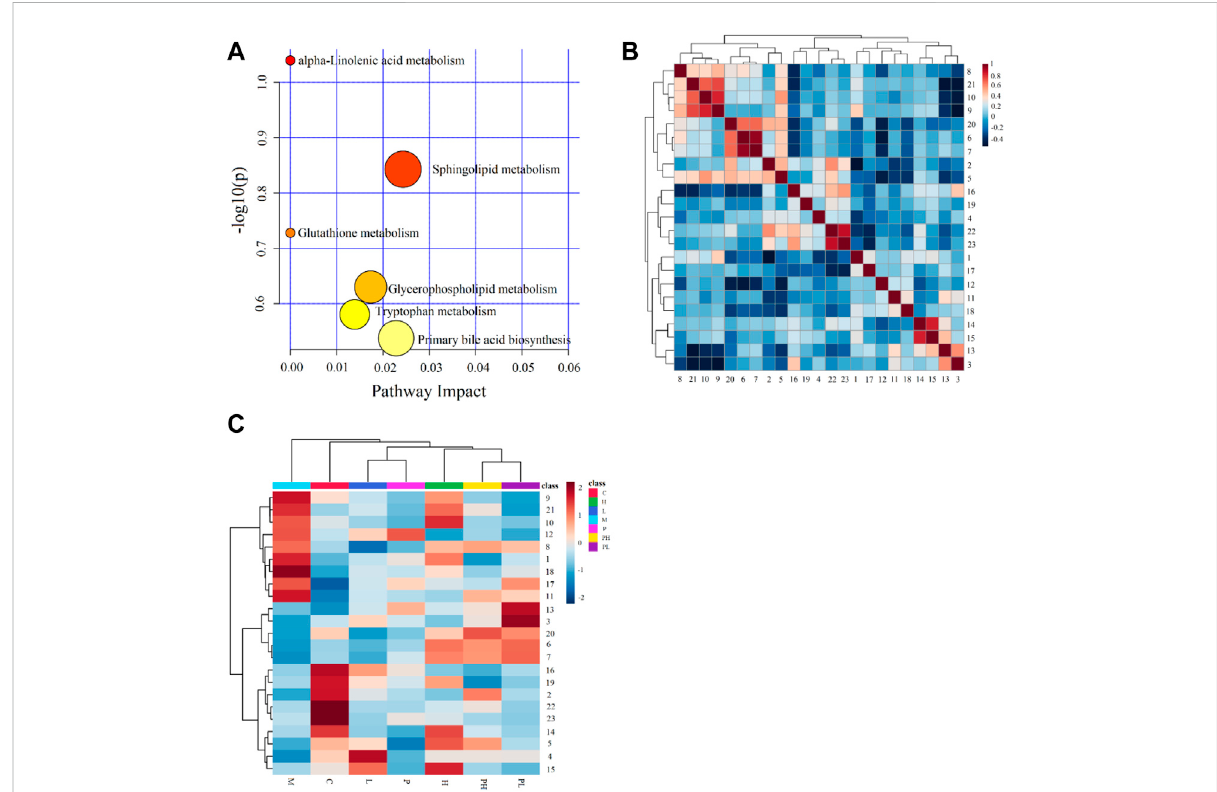
FIGURE 7 Pathway analysis of 23 differential metabolites of GYP on LLC mice (A) ; Pearson correlation analysis results of 23 differential metabolites, red indicates positive correlation and blue indicates negative correlation (B) ; Heatmap analysis of 23 differential metabolites among 7 groups (C) . (Metabolites1-23 represent Aminopropylcadaverine, Indoleacetaldehyde,3,5-Tetradecadiencarnitine,Pimelylcarnitine,LysoPC [18:3(6Z,9Z,12Z)/0: 0], LysoPE (18:0/0:0), LysoPC (15:0/0:0), LysoPC [22:6 (4Z,7Z,10Z,13Z,16Z,19Z)/0:0], LysoPC [20:2 (11Z,14Z)/0:0], LysoPE [0:0/22:1 (13Z)], Tetradecanoylcarnitine, 12,13-DHOME, Pseudouridine, Undecanedioic acid, 10,11-dihydro-20-trihydroxy-leukotriene B4, 12-Hydroxydodecanoic acid, Sphinganine 1-phosphate, Taurochenodesoxycholic acid, LysoPC [20:3 (8Z,11Z,14Z)/0:0], LysoPE (P-16:0/0:0), LysoPE [20:2 (11Z,14Z)/0:0], Stearidonic acid,